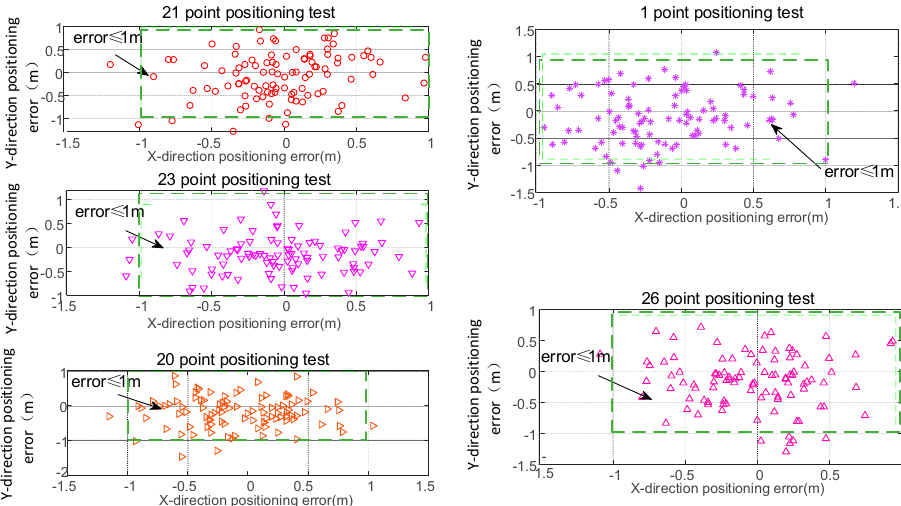
Figure 18. Positioning accuracy tests.